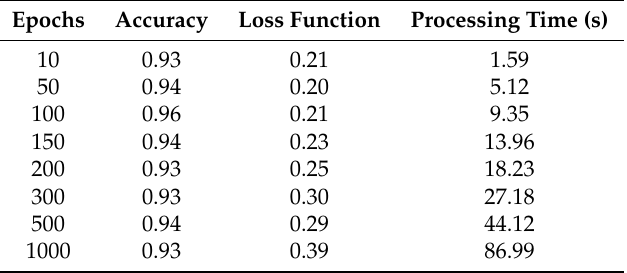
Table 2. Accuracy and loss function values using different number of